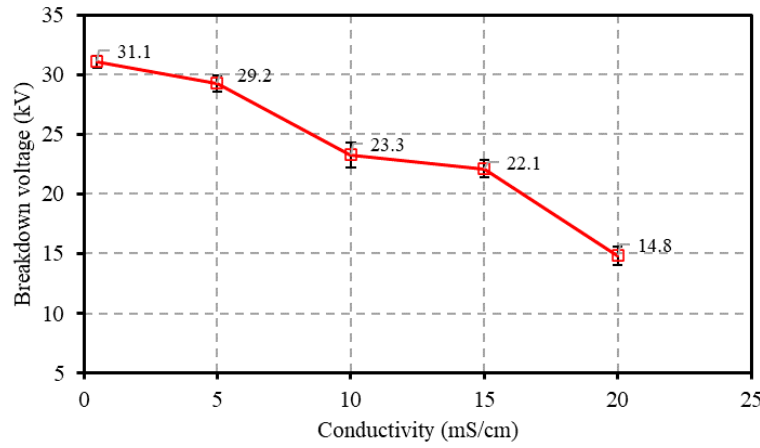
Figure 6. Breakdown voltage in water with different conductivity.